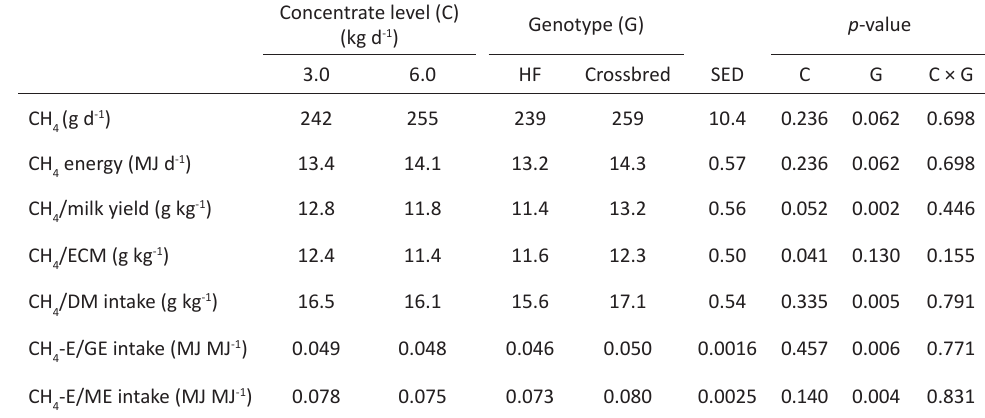
Table 2. Effect of concentrate feed level and cow genotype on methane (CH4) emissions from grazing dairy cows (mean of the three CH4 measurement